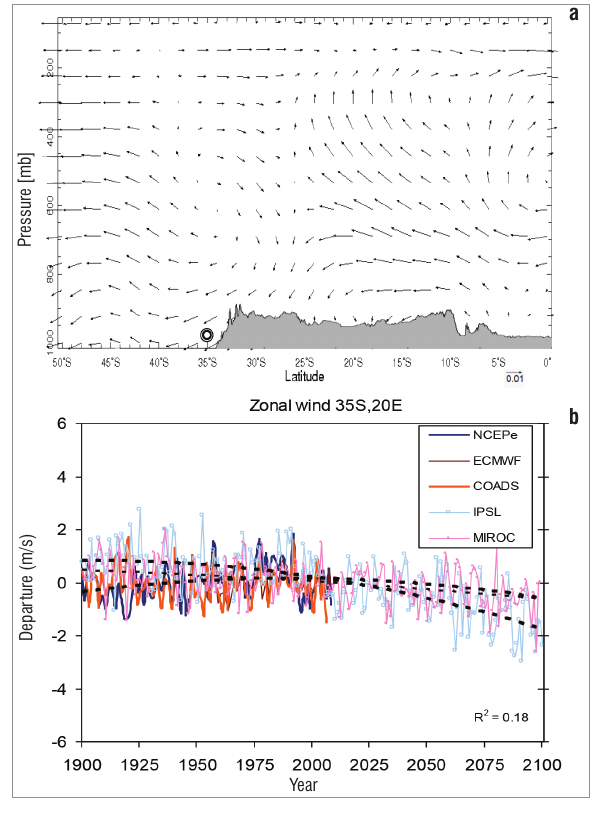
Figure 6: (a) NCEPr meridional circulation trend (m/s per year) averaged for the area from 20°E to 30°E for the period 1950–2010 with vertical motion exaggerated 40-fold. (b) Intercomparison of observed and modelled surface zonal wind trend at 35°S, 20°E (circle in (a)).